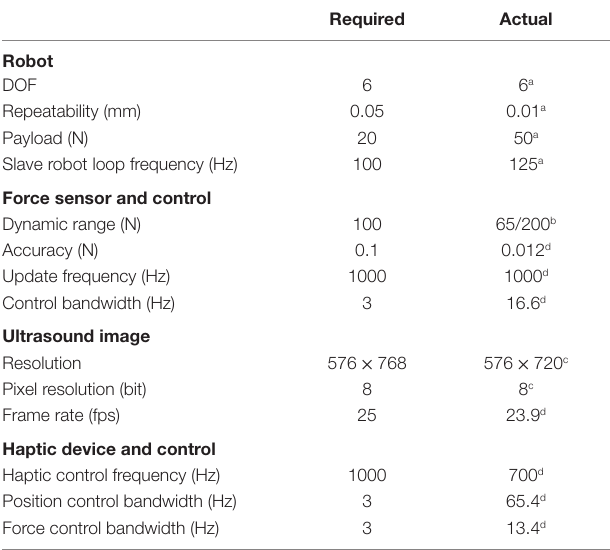
TaBle 5 | comparison of system requirements and actual properties.